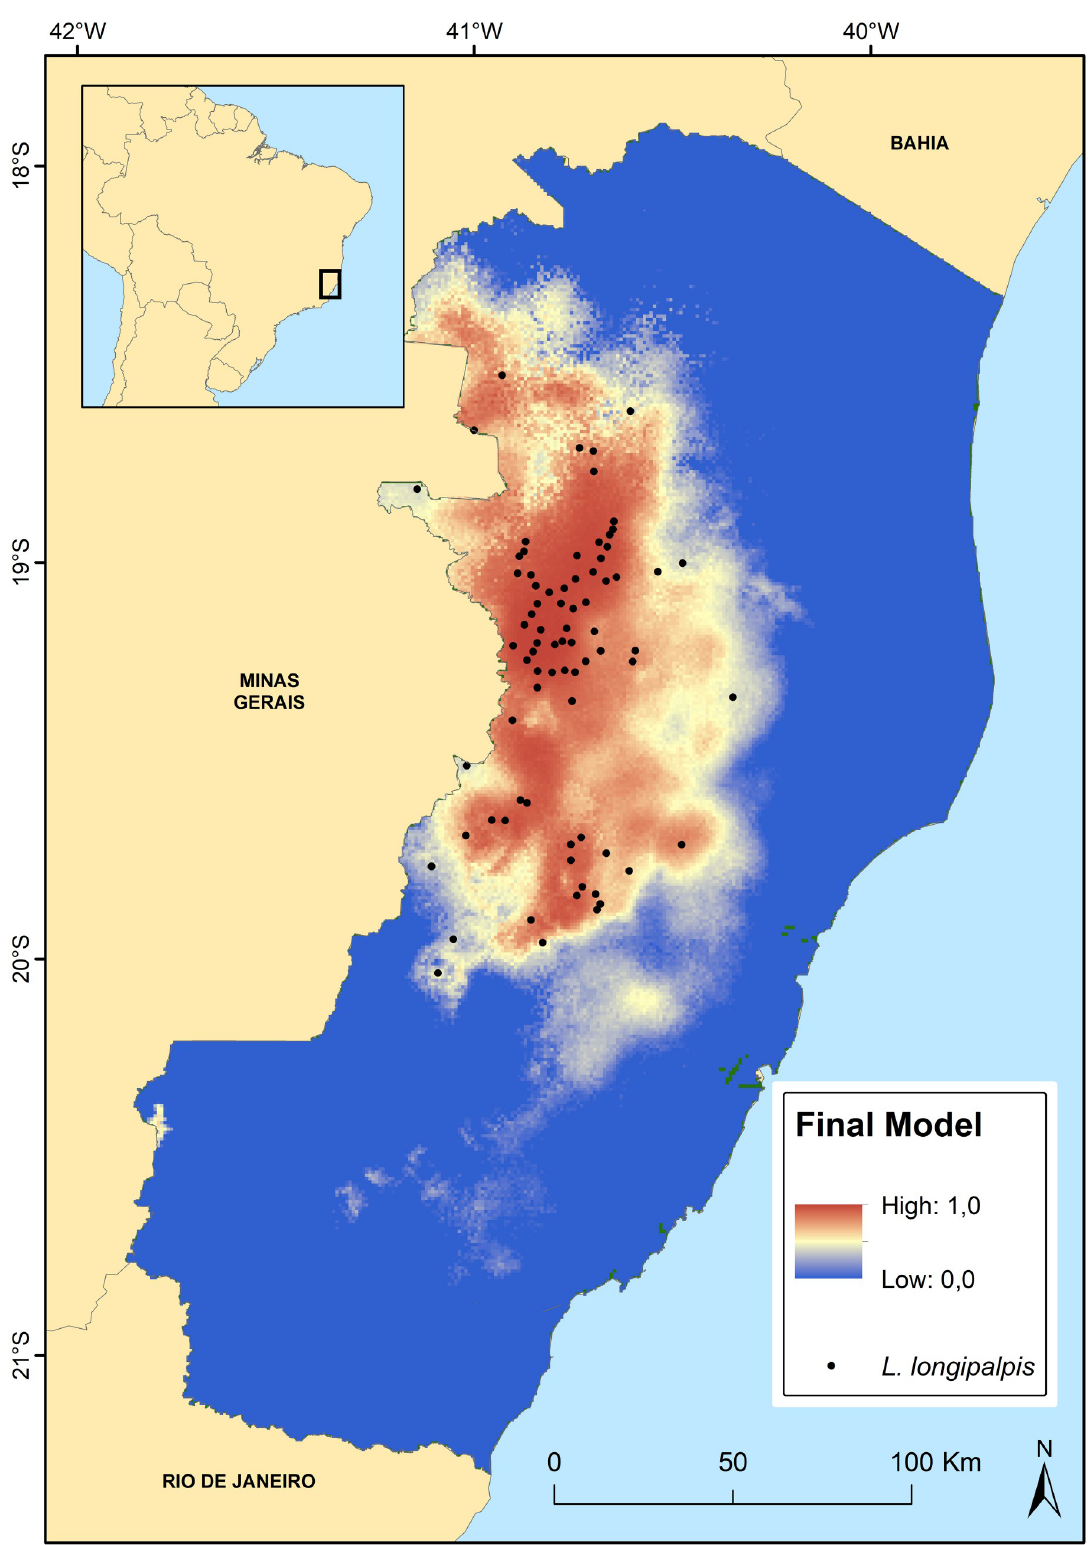
Fig 4. Final model normalized predicted distribution for Lutzomyia longipalpis in the state of Espı´rito Santo, southeastern Brazil. The occurrence points used in the modeling are also shown on the map.